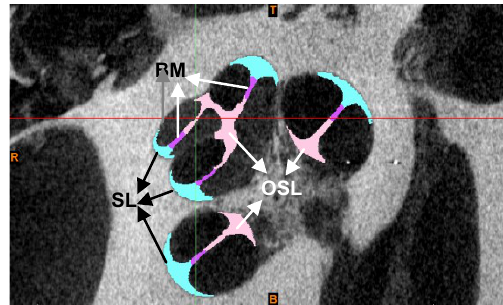
Fig.8. Segmentation of basilar membrane, spiral ligament and osseous spiral